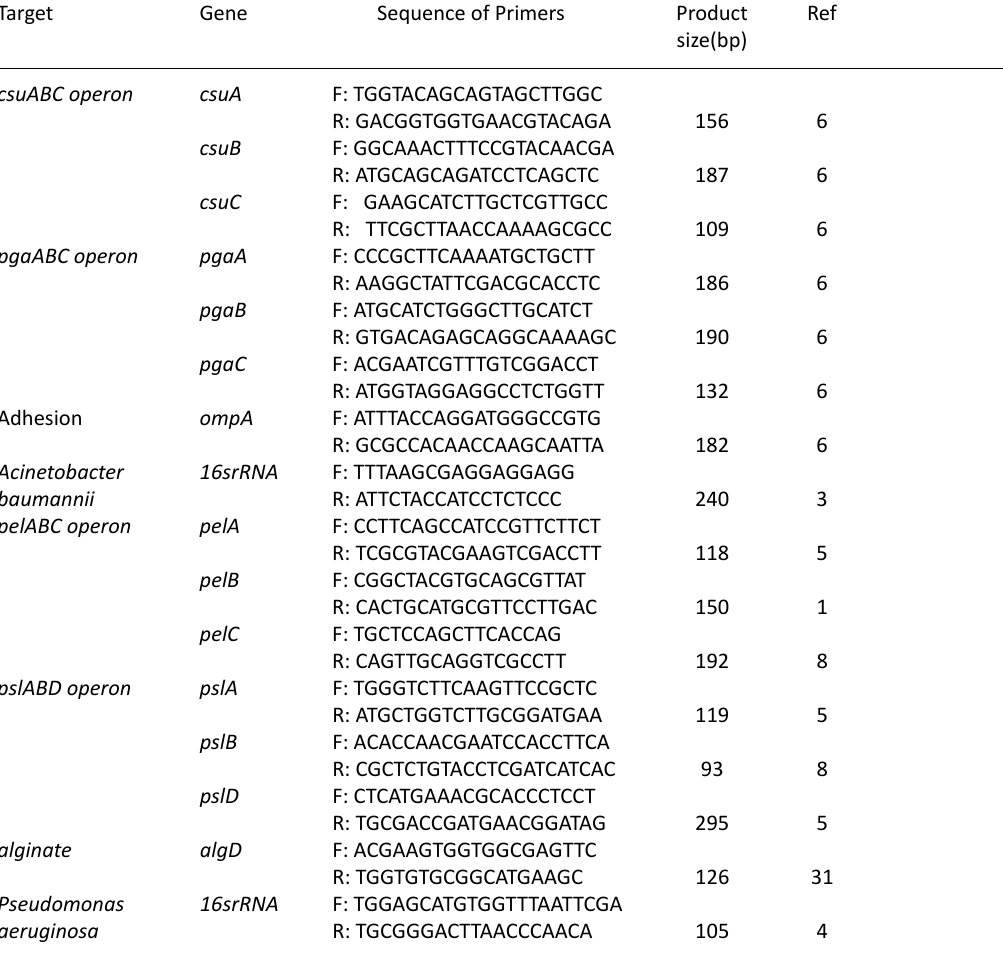
Table 1. Oligonucleotide sequences used in this study